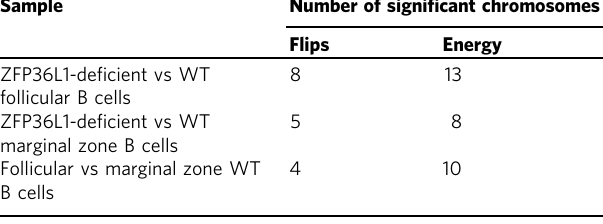
Table shows the numbers of chromosomes that had signi fi cantly (>2SD) reduced numbers of fl ips or increased energy in comparisons of changes in gene expression in ZFP36L1-de fi cient